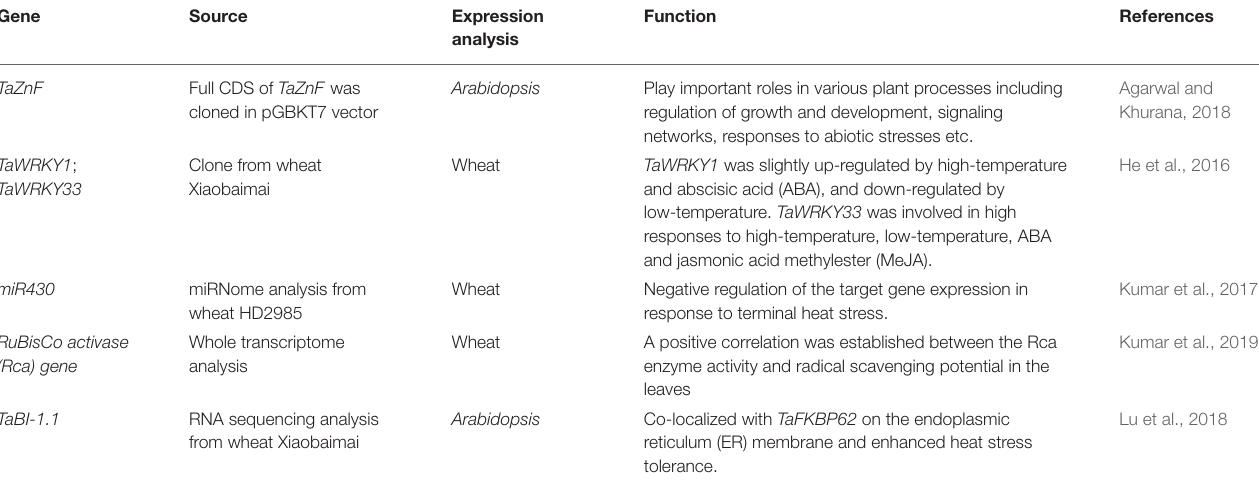
TABLE 5 | Putative genes for heat stress in wheat.